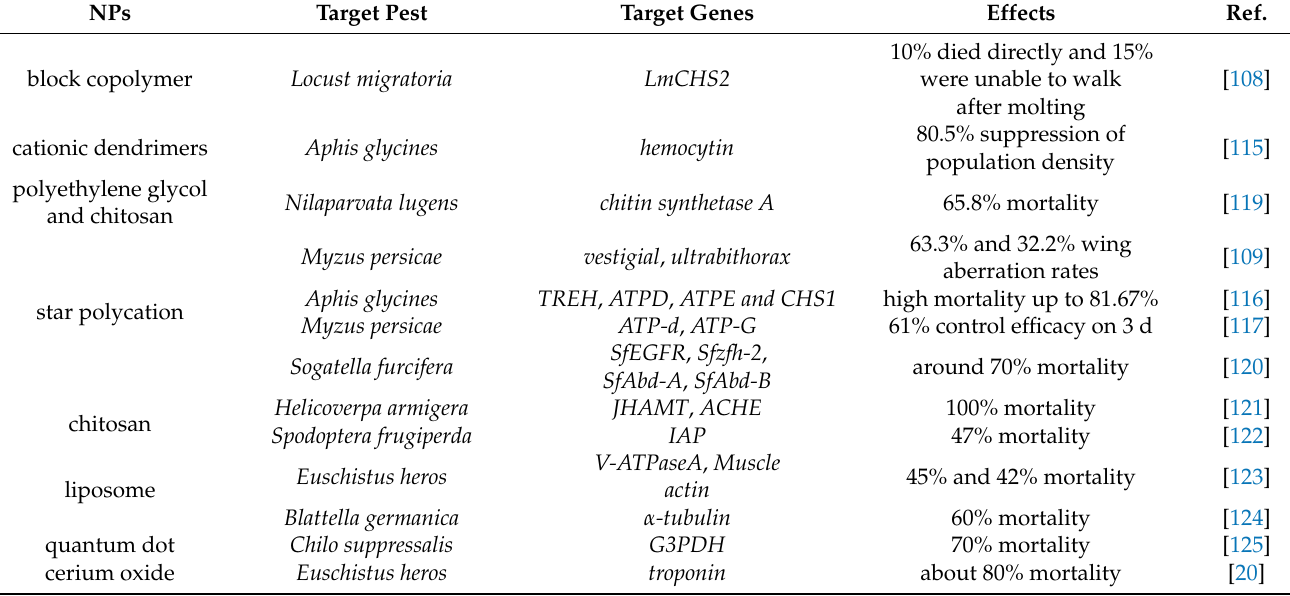
Table 1. Applications of NPs-mediated RNA pesticides for insect control.